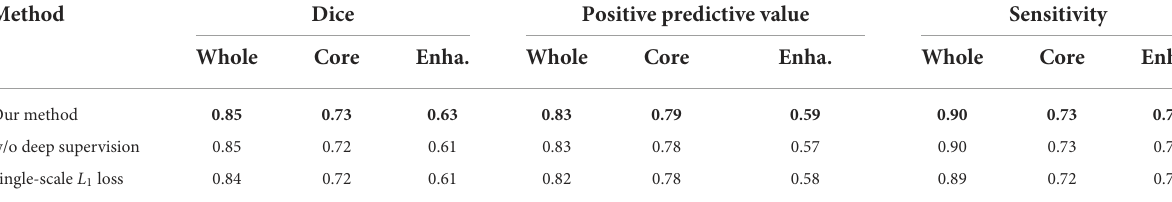
TABLE 5 Results of different loss function.